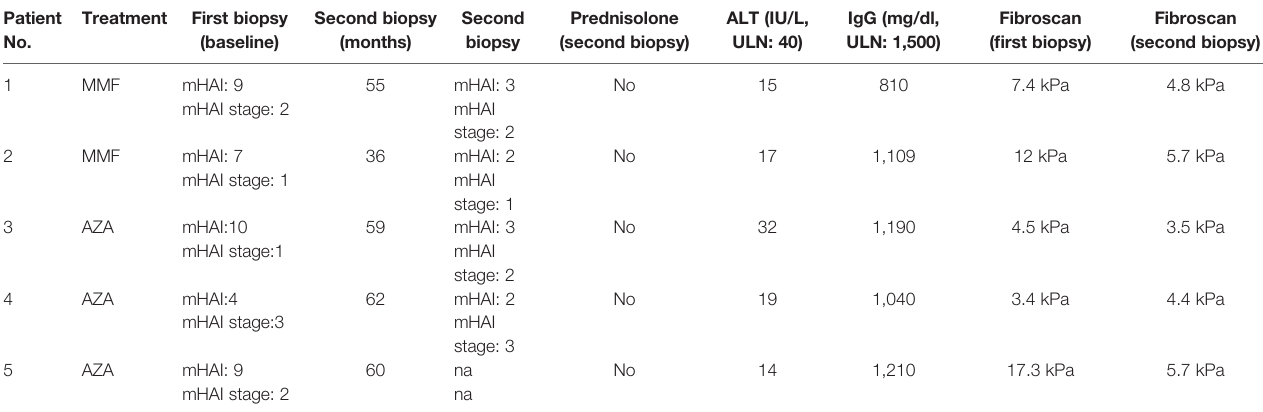
TABLE 4 | Liver histology data in 5 autoimmune hepatitis patients who stopped treatment. Patient Treatment First biopsy No.